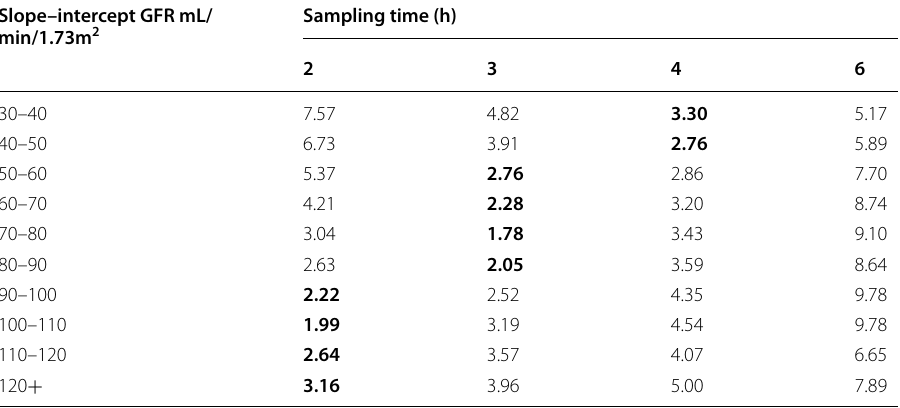
Lowest values are highlighted in bold